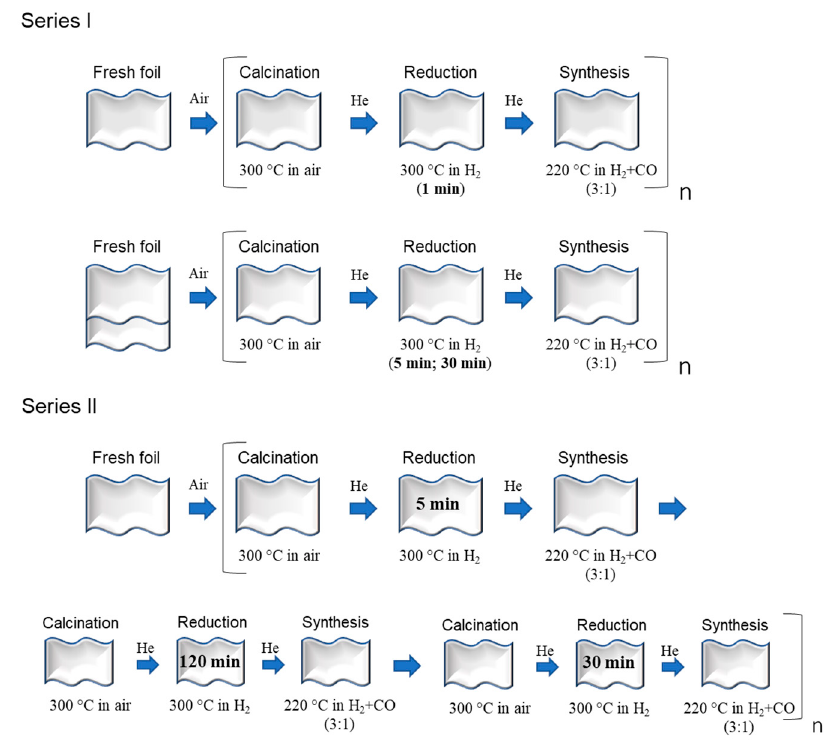
Figure 1. Activation of catalyst foils by repeated calcination in air and reduction in diluted hydrogen. Series I is based on three separate foils using reduction times of 1, 5, and 30 min, respectively, while one foil is used in series II with sequential change in reduction times and intermittent FT synthesis. Details, including calcination and flushing times, gas compositions, and ramping, are given in the Experimental Section.